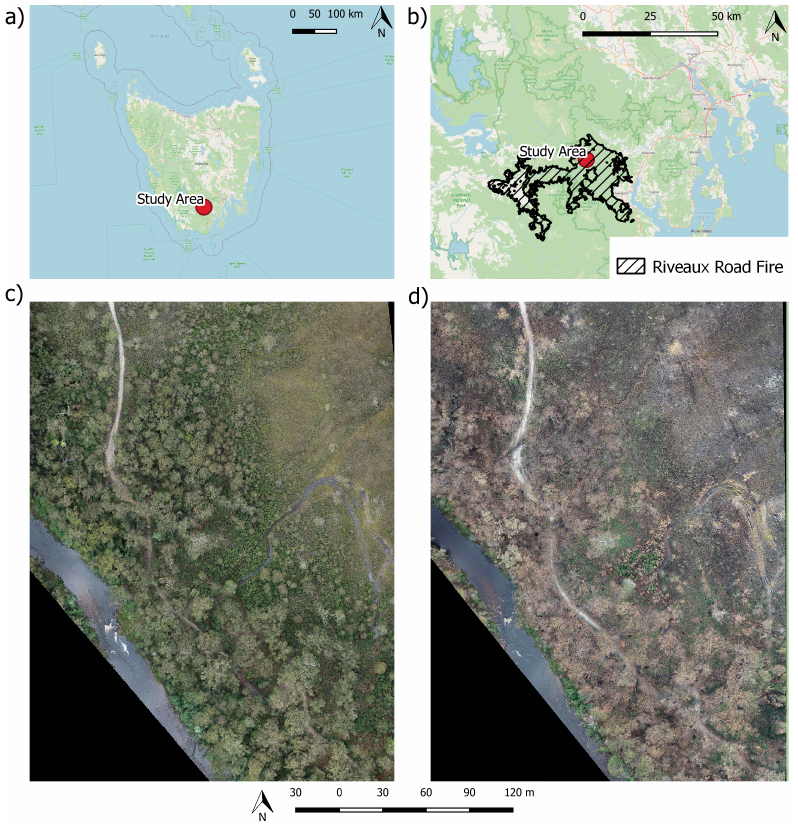
Figure 1. ( a ) The location of the site in Tasmania, Australia; ( b ) the location of the Riveaux Road Fire; ( c ) an image of the study area plot captured before the Riveaux Road fire complex (September 2018); and ( d ) an image of the study area plot captured post fire (May